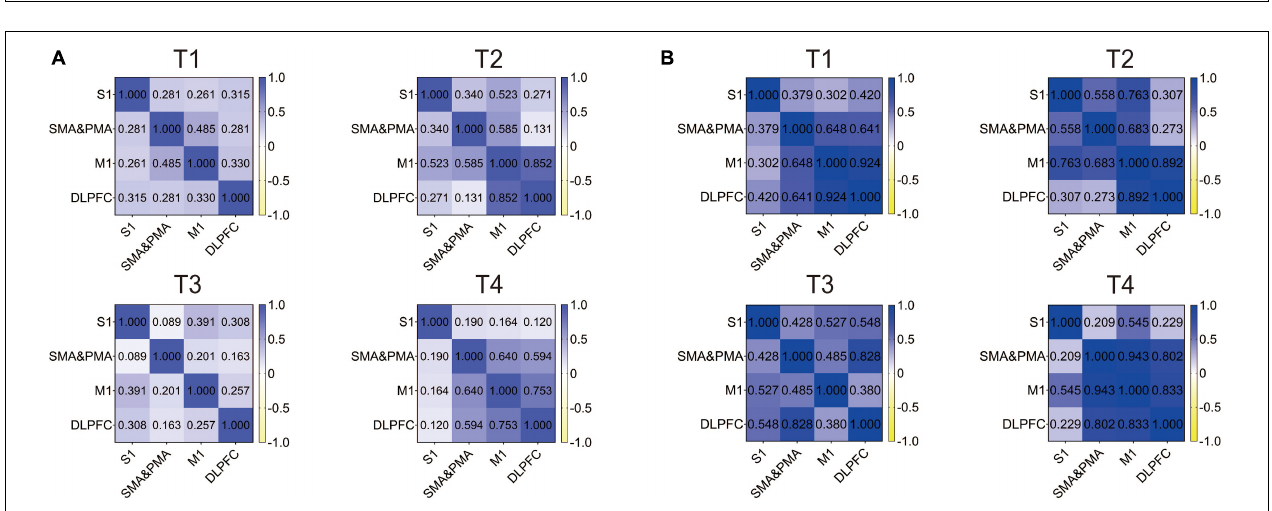
FIGURE 4 | Symmetric heat maps of T1, T2, T3, and T4, which represent the Pearson correlation index of 27 channels. (A) Non-resistance movement; (B) resistance movement. The change from white to dark blue indicates that the correlation level is from negative 0.8 to positive 1.